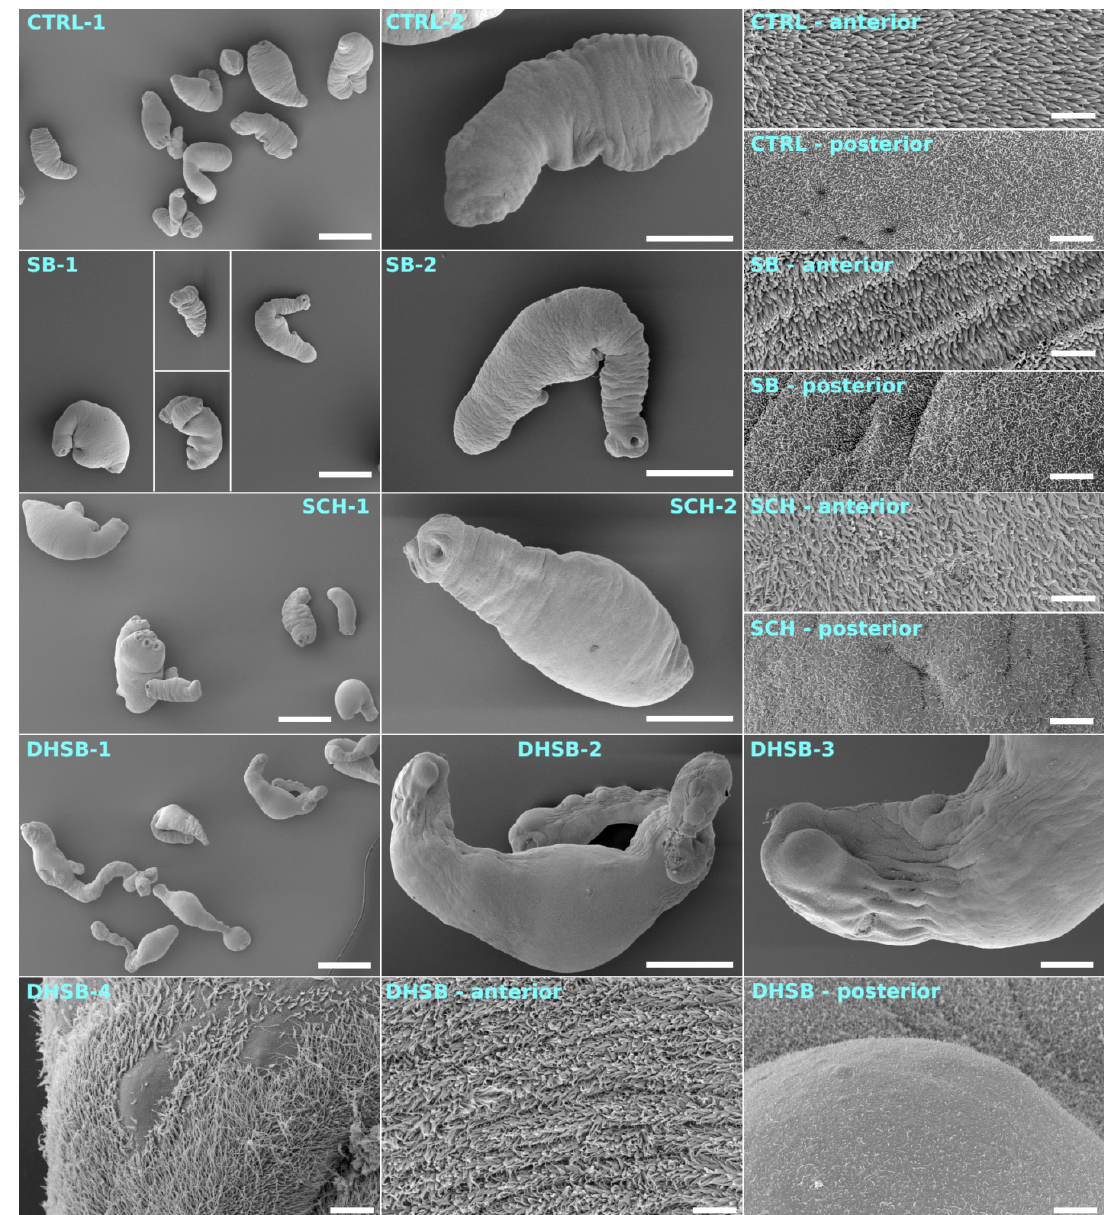
Figure 6. Effect of 50 μ M of SB, SCH and DHSB on whole larval morphology and tegumental alterations after 6 days of incubation were analyzed by scanning electron microscopy. Images placed in left panel (1) and middle panel (2) show shape and morphology of larvae in control (CTRL) and treated groups. Images localized in right and bottom panels represent high resolution microphotographs of tegumental surface on anterior and posterior parts of larvae. Elongation, flattening of larval bodies and narrowing of neck as well as severe damage to tegument seen as aneurysms of tegument and loss of microtriches at posterior part were recorded after DHSB exposure. Scale bars are as follows: CTRL-1, SB-1, SCH-1, DHSB-1—500 µ m; CTRL-2, SB-2, SCH-2, DHSB-2—200 µ m; DHSB-3—50 µ m; DHSB-4—5 µ m; all posterior and anterior—5 μ m.